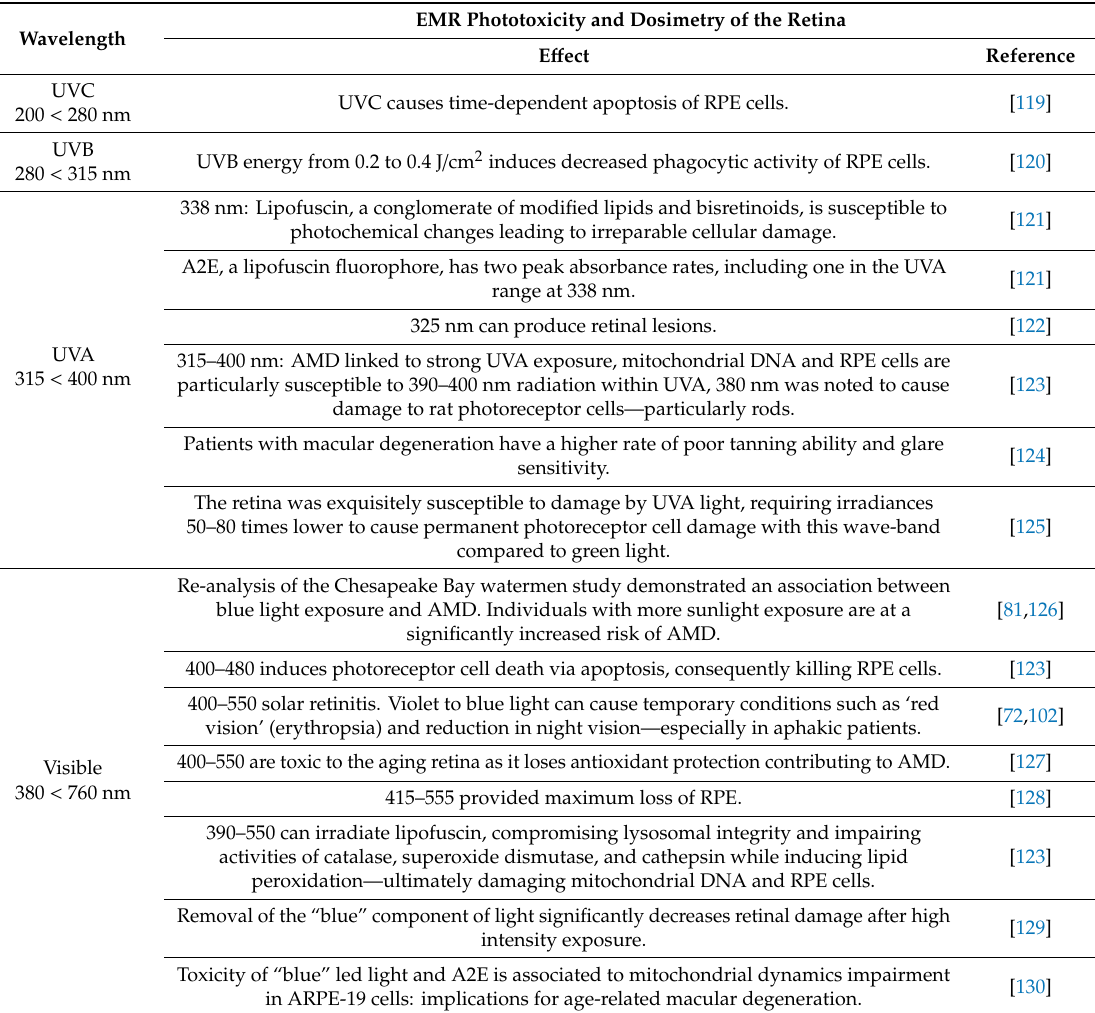
Table 5. Electromagnetic radiation action spectra and dosimetry thresholds for the